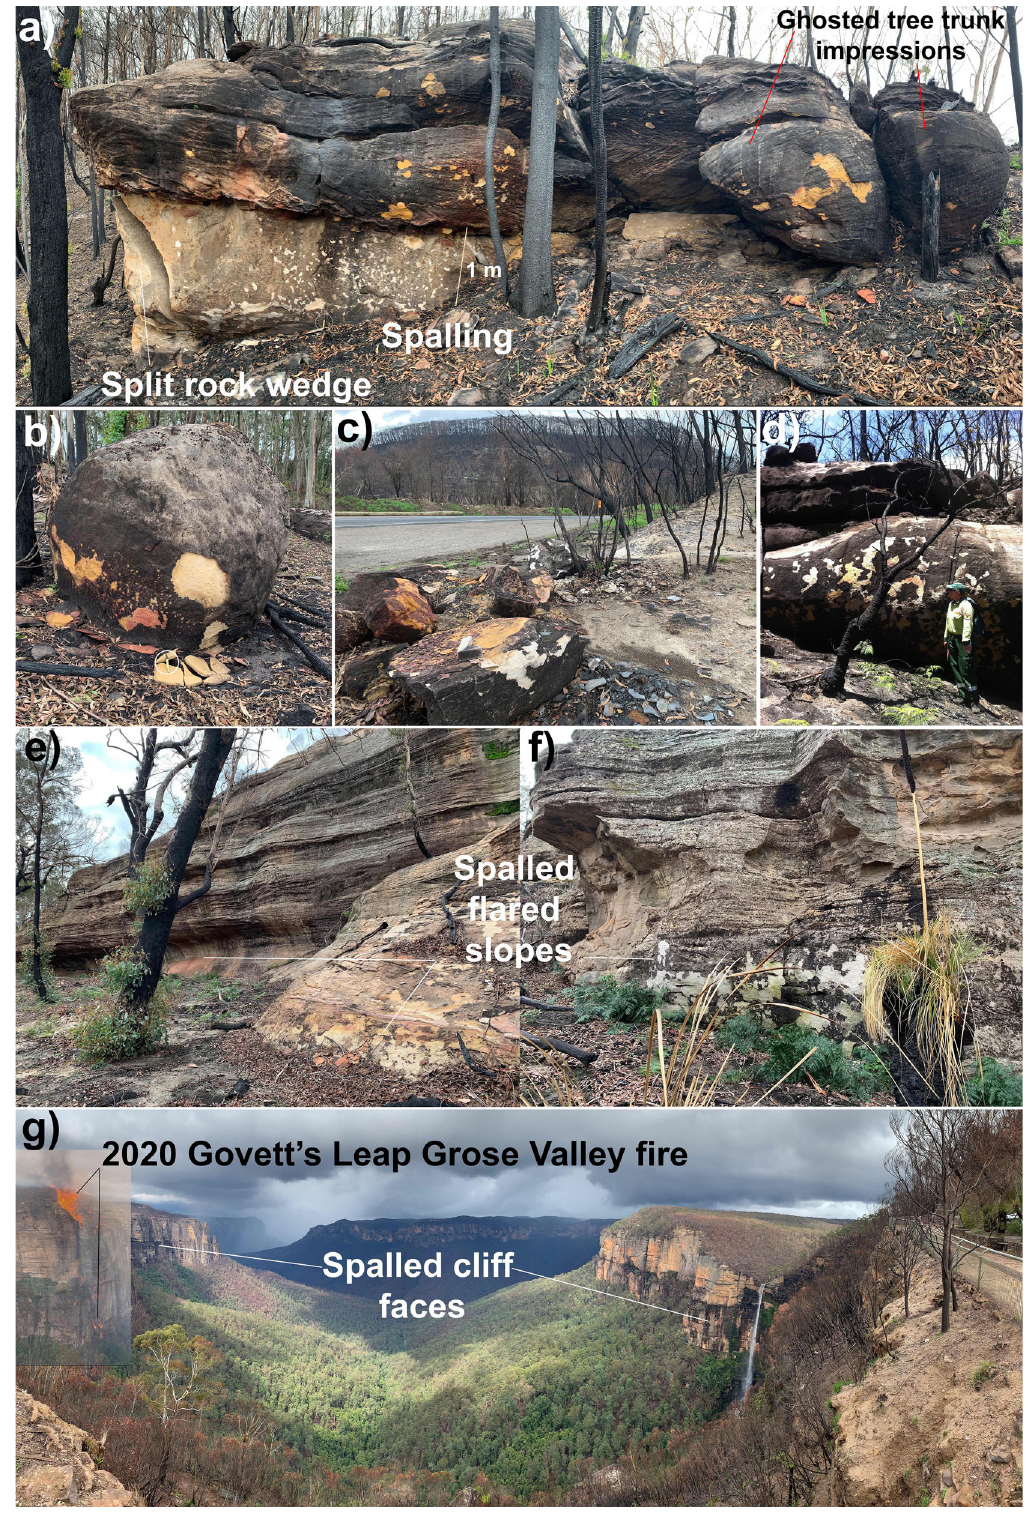
indication as to the long-term rates of erosion due to fi re-spalling at the base of an inselberg or cliff face where there is signi fi cant vegetation to fuel a wild fi re. The formula for erosion due to fi re-spalling.